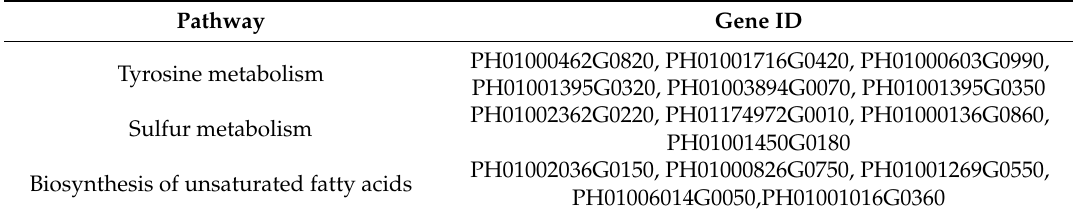
Table 6. P. edulis ‘Pachyloen’-specific genes in three significant